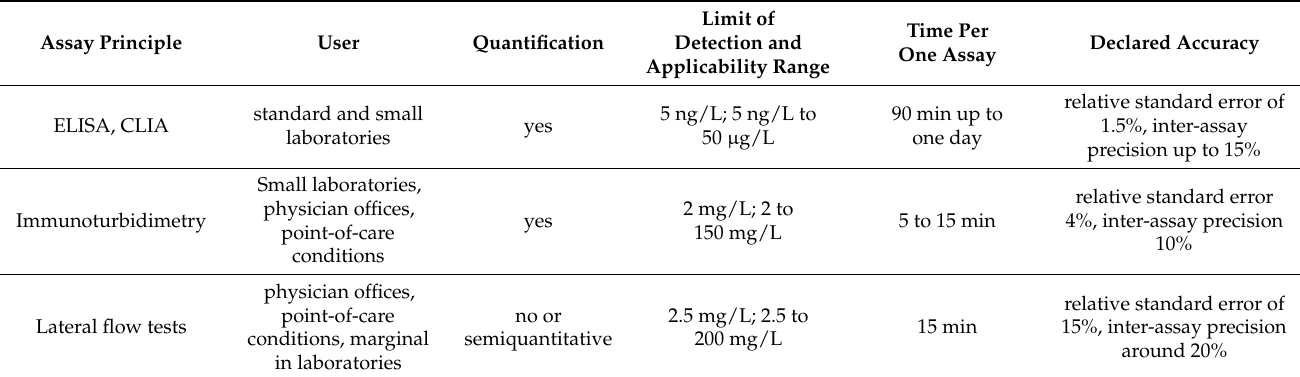
Table 2. General specification of CRP standard